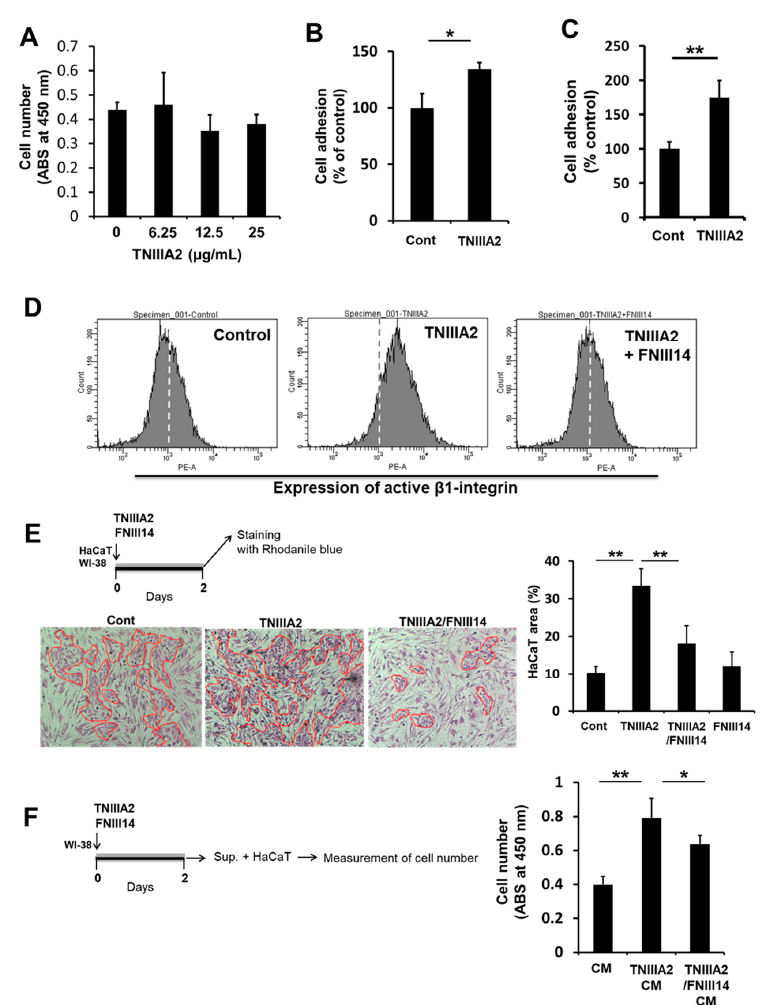
Figure 2. Peptide TNIIIA2 indirectly accelerated the proliferation of preneoplastic epithelial HaCaT cells via stimulation of WI-38 fibroblasts. ( A ) E ff ect of peptide TNIIIA2 (25 µ g / mL) on the proliferation of HaCaT cells. Cells were treated with peptide TNIIIA2 (25 µ g / mL) at the indicated concentrations. After 2 days, the number of cells was evaluated by WST-8 assay. ( B ) HaCaT cells were seeded with or without peptide TNIIIA2 (25 µ g / mL) into 96-well plates coated with fibronectin (1.0 µ g / mL). Adhered cells were measured by crystal violet staining and counted under a microscope. ( C ) WI-38 cells were seeded with or without peptide TNIIIA2 (25 µ g / mL) into 96-well plates coated with fibronectin (1.0 µ g / mL). Adhered cells were measured by crystal violet staining and counted under a microscope. ( D ) WI-38 cells were incubated with or without peptide TNIIIA2 (25 µ g / mL) in the presence or absence of peptide FNIII14 (50 µ g / mL) for 30 min. Activation status of β 1-integrin was evaluated by flow cytometry using antibody AG89 recognizing the active β 1-integrin conformation-specific epitope. ( E ) HaCaT cells were co-cultured with WI-38 in the presence or absence of peptide TNIIIA2 (25 µ g / mL), peptide FNIII14 (50 µ g / mL) or their combination for 2 days as described in Materials and Methods. Cells were stained with 1% Rhodanile blue for epithelial cells staining. Proliferation of HaCaT cells were evaluated as described in Materials and Methods. ( F ) WI-38 cells were treated in the absence or presence of peptide TNIIIA2 (25 µ g / mL) and peptide FNIII14 (50 µ g / mL) for two days, and the culture supernatants were collected as conditioned medium (“CM”: control, “TNIIIA2 CM”: cultured with TNIIIA2, “TNIIIA2 / FNIII14 CM”: cultured with TNIIIA2 in the presence of FNIII14). Preneoplastic HaCaT cells were then cultured with each of these conditioned media. Two days later, the number of viable cells was evaluated by WST-8 assays, as described in the ‘Materials and Methods’. Data represent the means ± standard deviation of triplicate determinations, * p < 0.05, ** p <